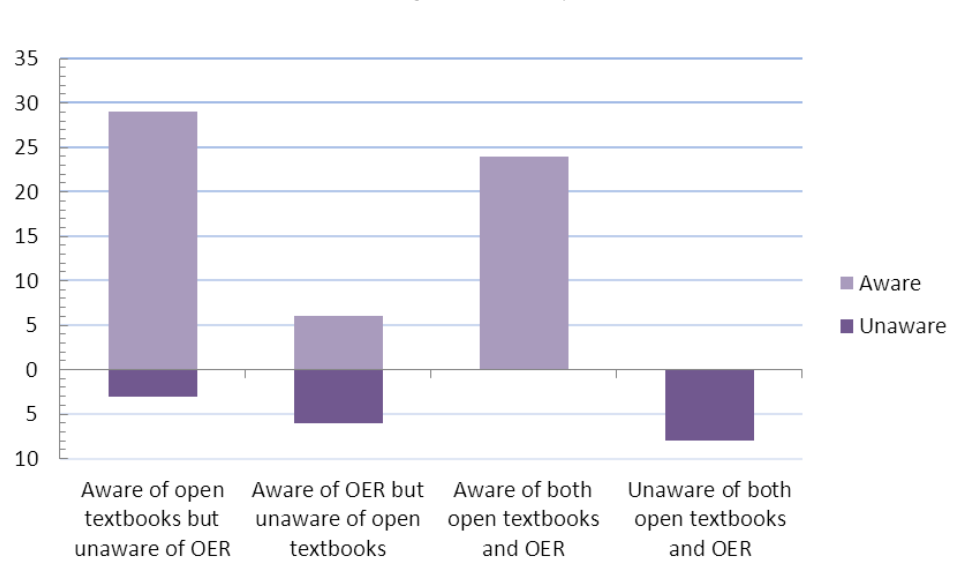
Figure 2 . Awareness on open textbooks and OER over four teacher